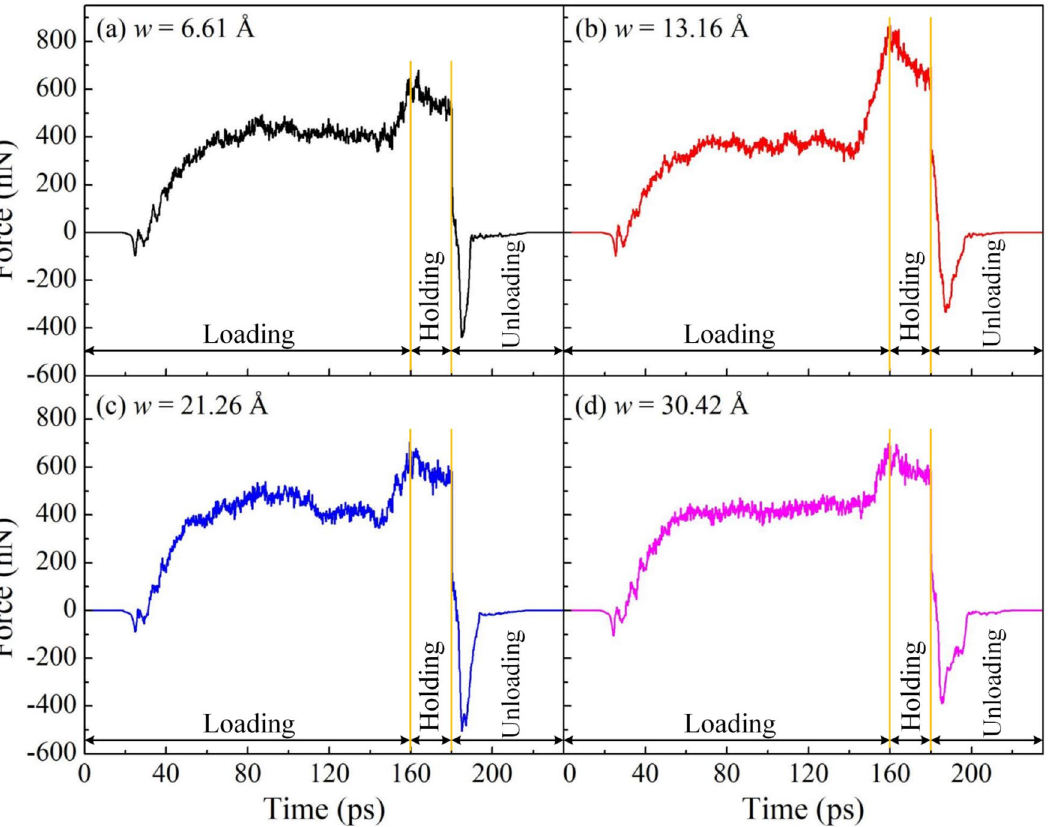
Figure 13. The force–time diagrams for NT-polycrystalline workpieces during nanoimprinting with various TB distances: 6.61 Å ( a ); 13.16 Å ( b ); 21.26 Å ( c ); and 30.42 Å ( d